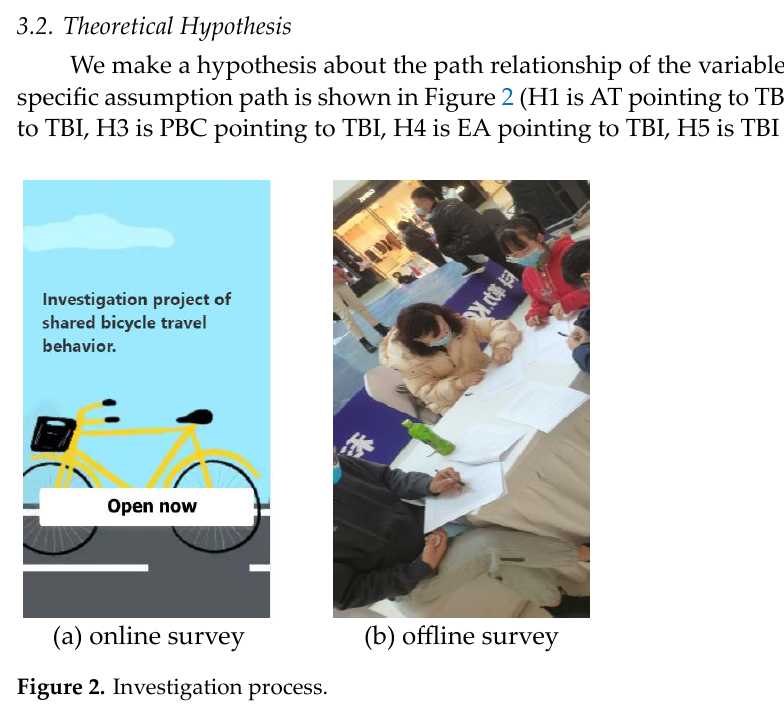
Figure 1. Travel behavior model. TBI repeted in the legenda.